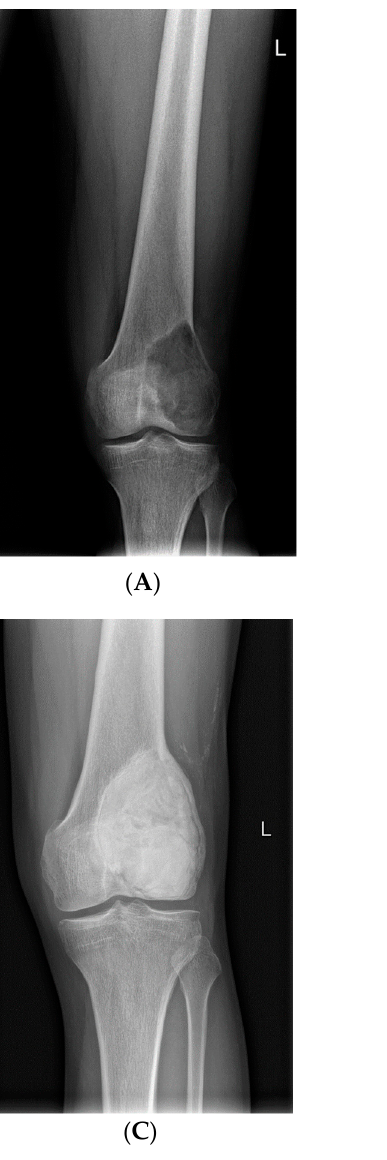
Figure 6. GCTB of the distal femur (X-rays). ( A ) Before denosumab therapy, ( B ) after 6 doses of denosumab, and ( C ) after intralesional curettage and PMMA cementoplasty. Computed tomography (CT) scans show tumor matrix and marginal sclerosis. Before